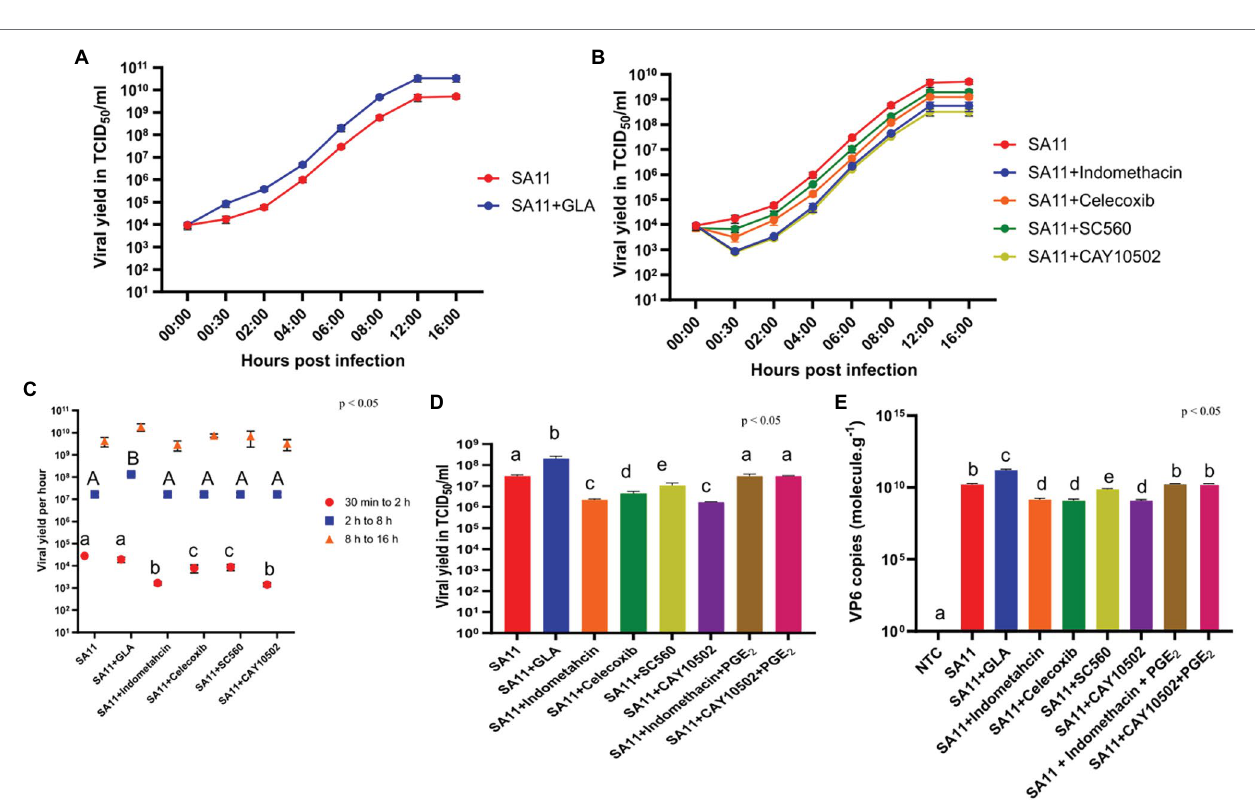
FIGURE 4 | GLA supplementation and treatment with inhibitors of PGE2 biosynthesis affect RV replication. (A) Rotavirus yield determined by TCID 50 was compared to SA11-infected MA104 cells, in the presence and absence of GLA and (B) inhibitors of the PGE 2 -biosynthetic pathway at several time points post-infection. (C) The replication rate of rotavirus as determined by calculating the slope between 30 min and 2 h (red), 2 h and 8 h (blue) or 8 h and 16 h (orange), was compared to SA11-infected MA104 cells, in the presence and absence of GLA and inhibitors of the PGE 2 -biosynthetic pathway. (D) Rotavirus yield as determined by TCID 50 and (E) copy number of VP6 as determined by RT-qPCR was compared to SA11-infected MA104 cells, in the presence and absence of GLA and inhibitors of the PGE 2 - biosynthetic pathway at 6 h post-infection. Error bars indicate the standard error of the mean ( n = 3). Lowercase and uppercase letters indicate significant difference ( p < 0.05) compared to the